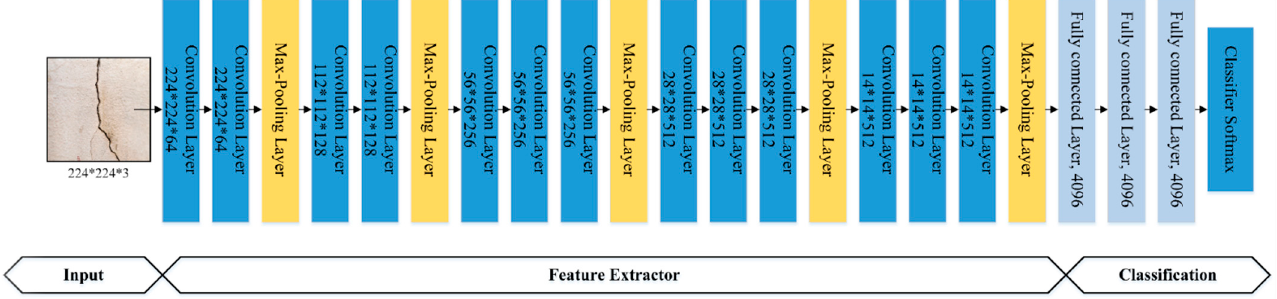
Figure 4. The architecture of the VGG-16 model.